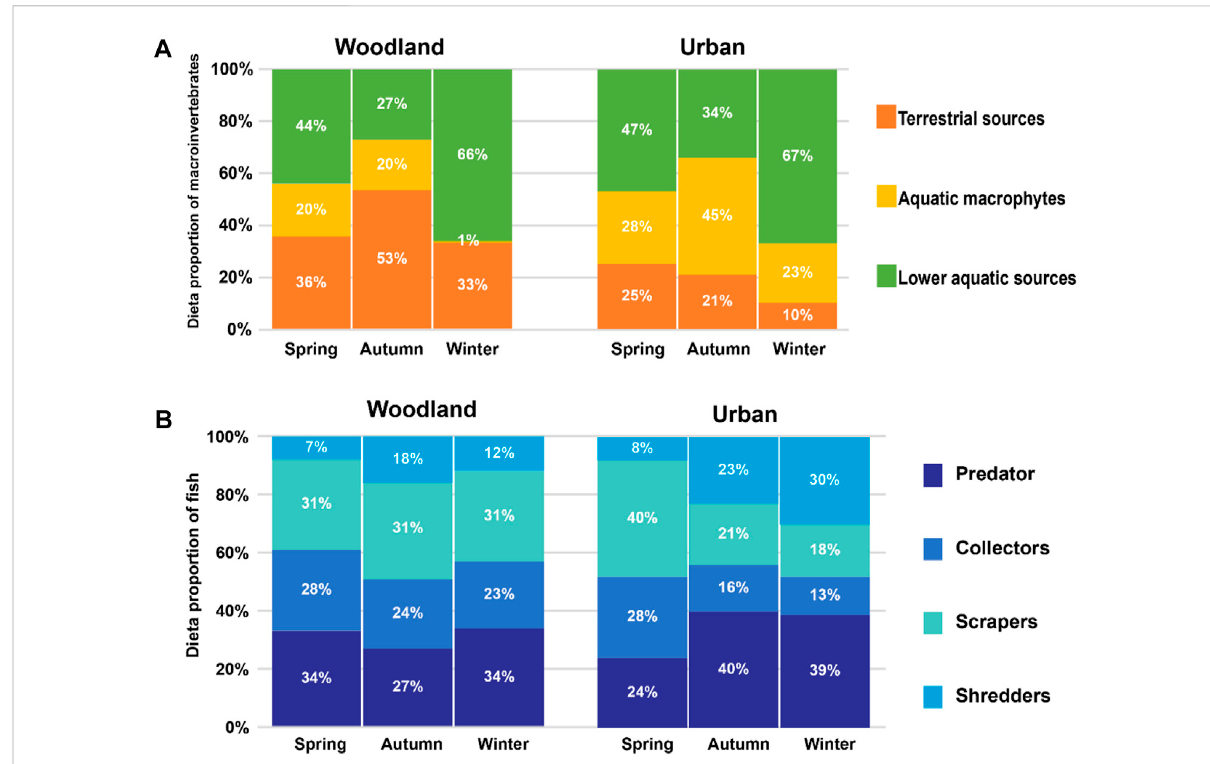
FIGURE 3 The proportions of dietary sources for (A) macroinvertebrates and (B) fi sh at woodland and urban sites in spring, autumn, and winter.